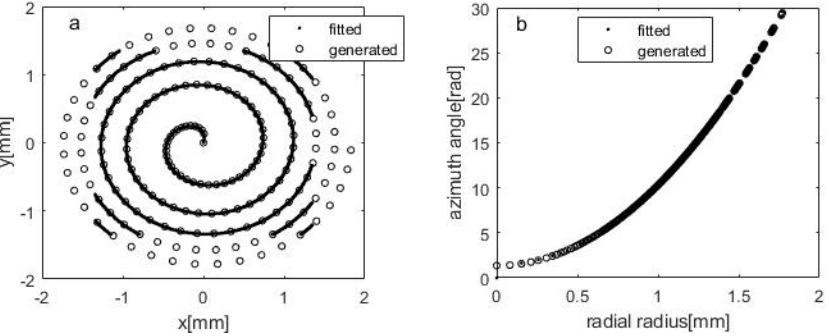
Figure 4. Results of spiral recovering (m = 1), ( a ) Comparison of two spirals, numerically generated (circles) and fitted (points), recovered spiral equation is ϕ = 8.95 r 2 + 1.35; ( b ) Comparison of radial radius and azimuthal angle of both spirals.